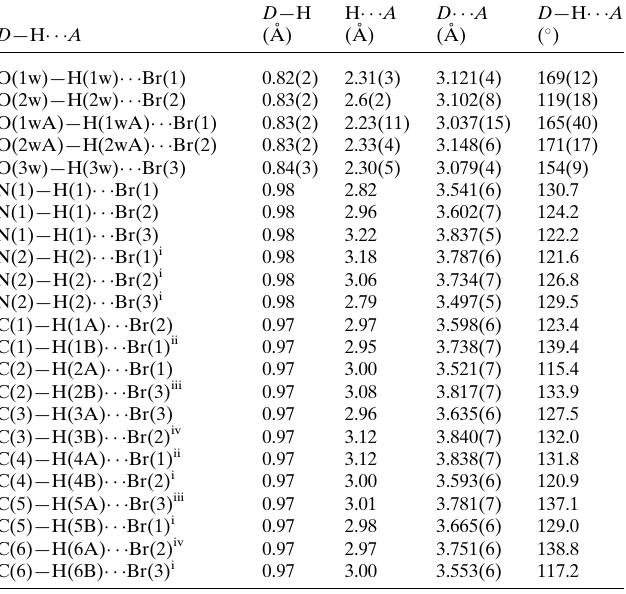
Table 3 Shortest interionic contacts corresponding to hydrogen bonds NH (cid:3)(cid:3)(cid:3) Br and OH (cid:3)(cid:3)(cid:3) Br in (cid:3) -[dabcoH 2 ] 2+ [H 3 O] + Br (cid:2) 3 ; cf . Table 2. D —H (cid:3)(cid:3)(cid:3) A